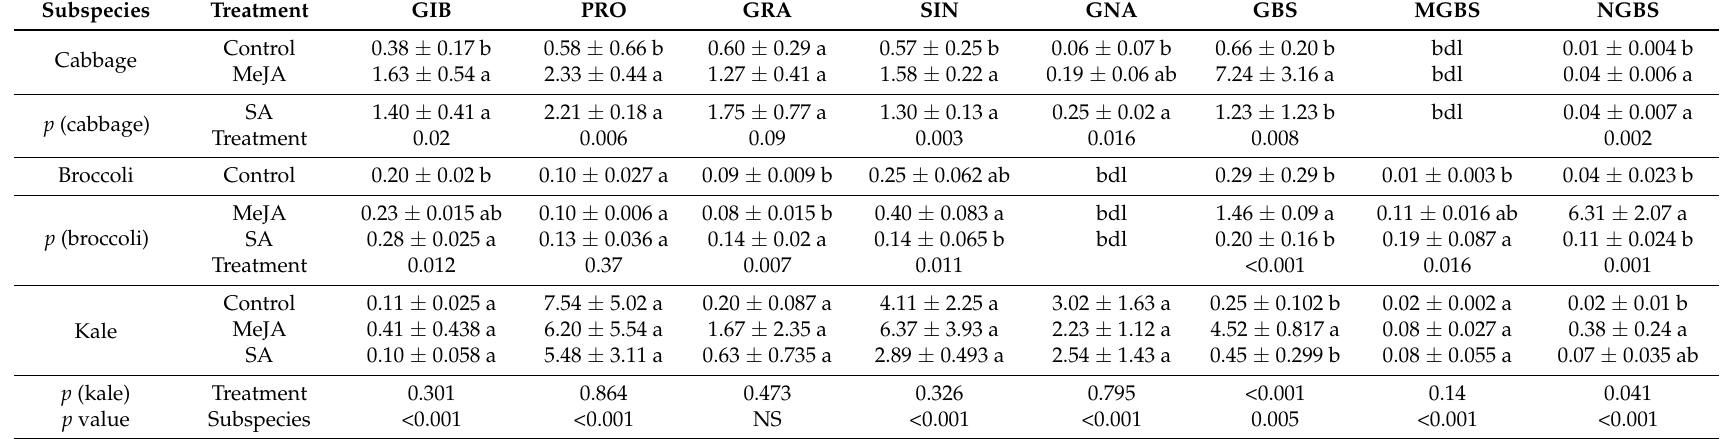
Table 1. Contents of aliphatic and indolic glucosinolates ( µ mol · g − 1 · DW) produced under the exogenous application of MeJA and SA in three B. oleracea subspecies. Subspecies